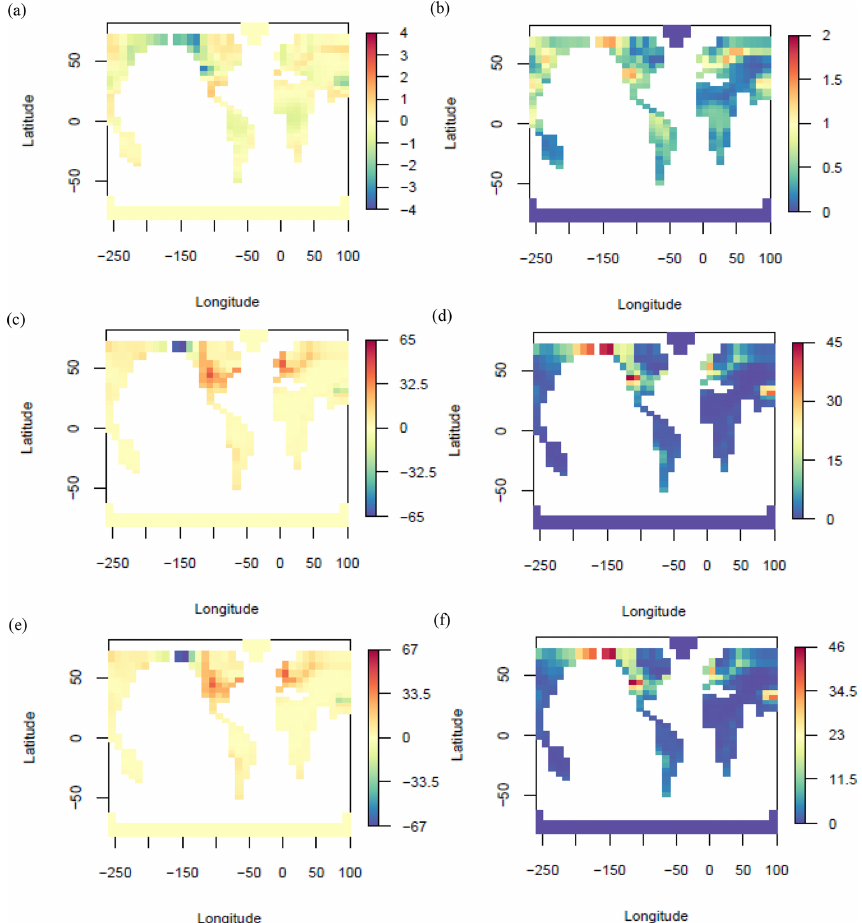
Figure 11. LGM vegetation (a–b) , soil (c–d) and total terrestrial carbon changes (e–f) ENS 104 mean (a, c) and standard deviation (b, d) . Units are kgCm − 2 .